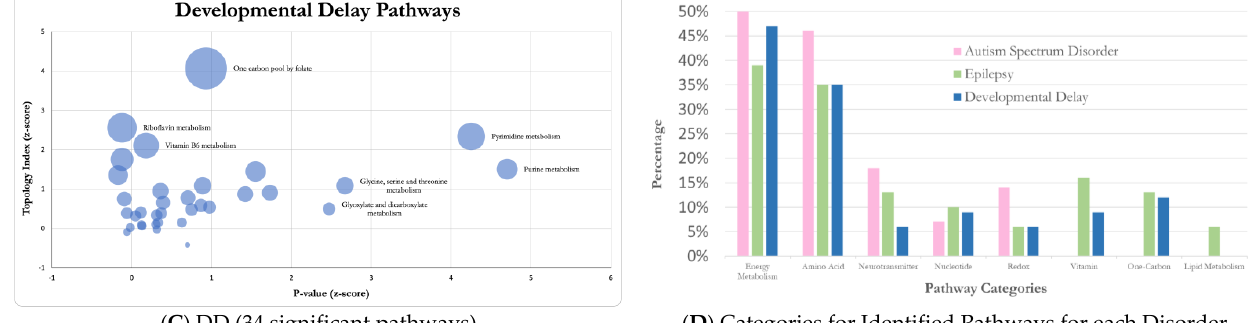
Figure 2. Major Nodes for Metabolite–Metabolite Interaction Networks for ( A ) Autism Spectrum Disorder (ASD), ( B ) epilepsy (EPI) and ( C ) Developmental Delay (DD) as well as ( D ) Categories for Pathways Identified for each